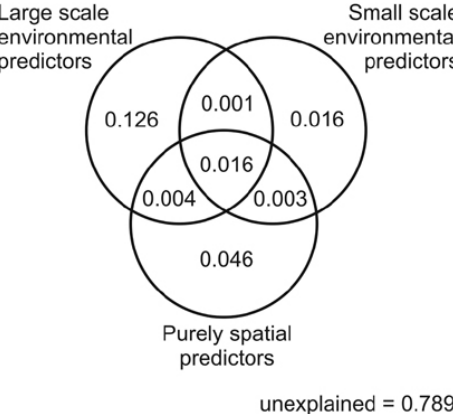
Fig. 6. Venn-diagram showing the partitioning of the explained variance of gastropod community compositions in Lake Ohrid into fractions of predictors and their combinations. The figure indi- cates that large scale environmental predictors (i.e. collecting depth, slope, and collecting depth:slope) alone can explain most of the sim- ilarity between gastropod communities. This is followed by purely spatial predictors (i.e. 7PCNMs) and small scale environmental pre- dictors (i.e. chlorophyll- a , total organic carbonate, and substrate forming bedrock). Note that the square root of the community dis- similarity measure was used. Therefore the adjusted explained vari- ance is lower than given in Table 1. For detailed explanations see the Material and method